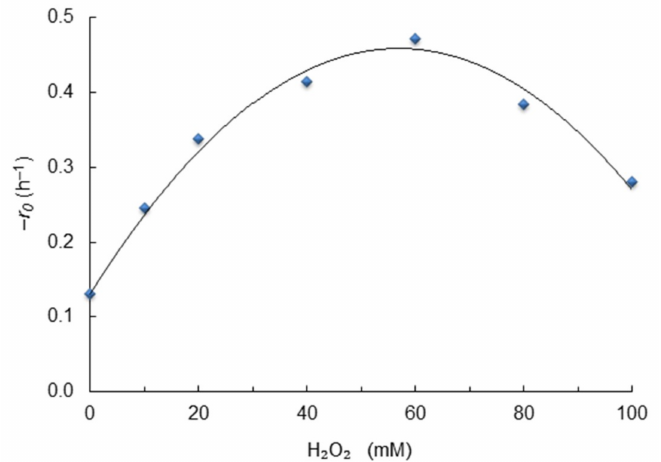
Figure12. InitialrateofReactiveViolet5(RV5)removalasafunctionofhydrogenperoxideconcentration (c 0 RV5 = 30 ppm; pH = 10; catalyst load = 3 g /